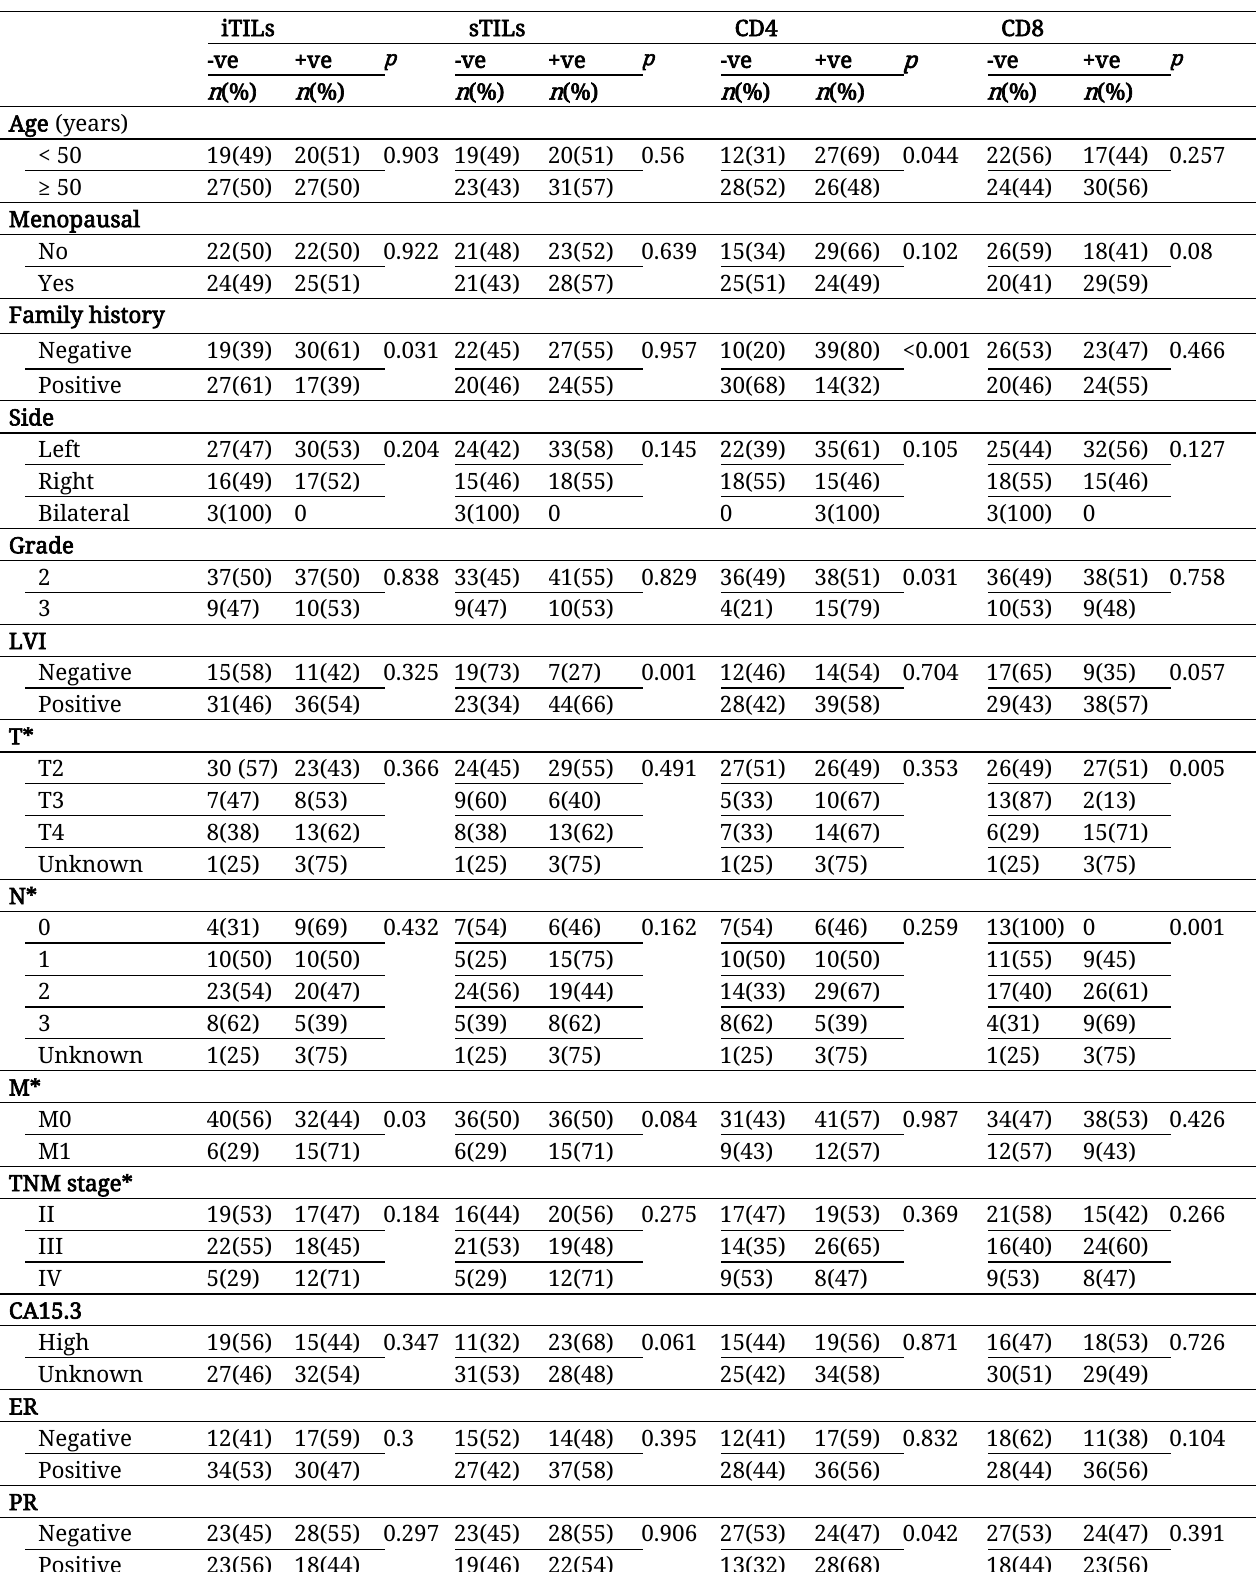
Table 3: The relationship between iTILs, sTILs, CD4, and CD8 and clinicopathological variables